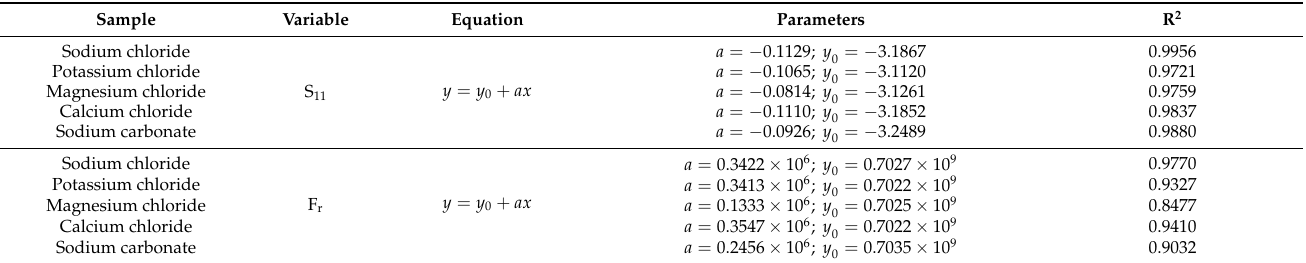
Table 4. The equations and parameters of this relationship for each salt in the frequency range of the third resonance peak.